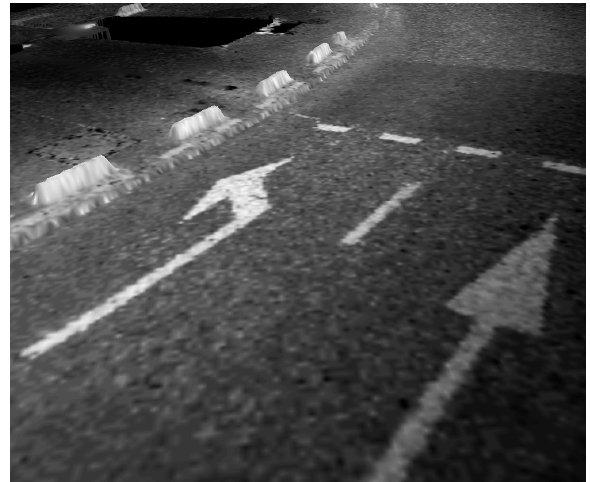
Figure 9: Digital Terrain Model textured with the reflectance or- thophoto poles, ...) would appear with color codes to distinguish them,